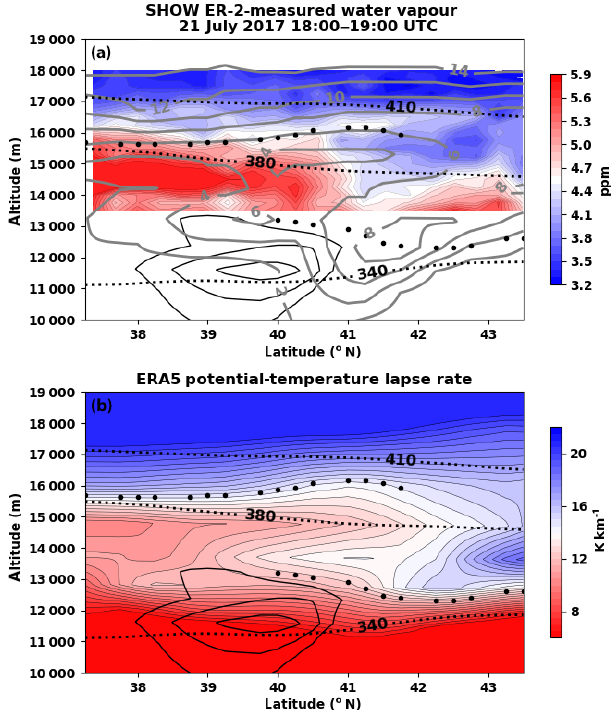
Figure 6. SHOW-measured water vapour profile (from 18:00 to 19:00UTC) (a) and the potential-temperature lapse rate determined from the ERA5 reanalysis for the 19:00UTC time step along the SHOW measurement track (b) . The dark dotted line shows the lo- cation of the thermal tropopause. The grey contours show the poten- tial vorticity; several zonal wind contours are shown in black; and the light black dotted line shows the 340, 380, and 410K isentropes respectively. The longitude is along the 124.5 ◦ W line and is nearly constant for the